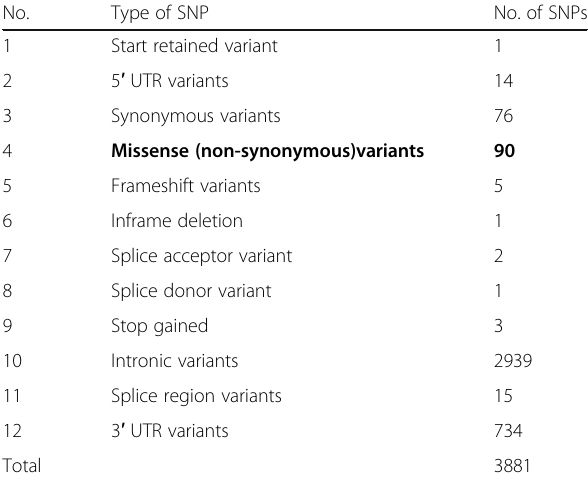
Table 1 Distribution of the retrieved SNPs of the bovine LEP gene. The bolded SNPs were the nonsynonymous SNPs that are selected for the present comprehensive